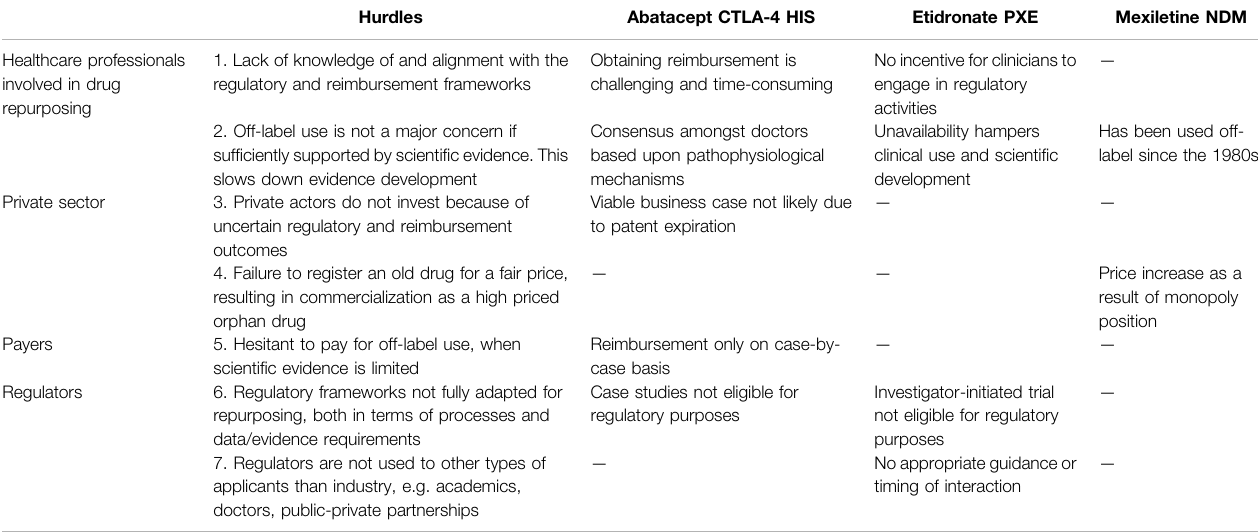
TABLE 2 | Identi fi ed hurdles in the three cases of drug repurposing for rare diseases. CTLA-4 HIS: cytotoxic T-lymphocyte antigen four haploinsuf fi ciency. PXE: pseudoxanthoma elasticum. NDM: Non-dystrophic